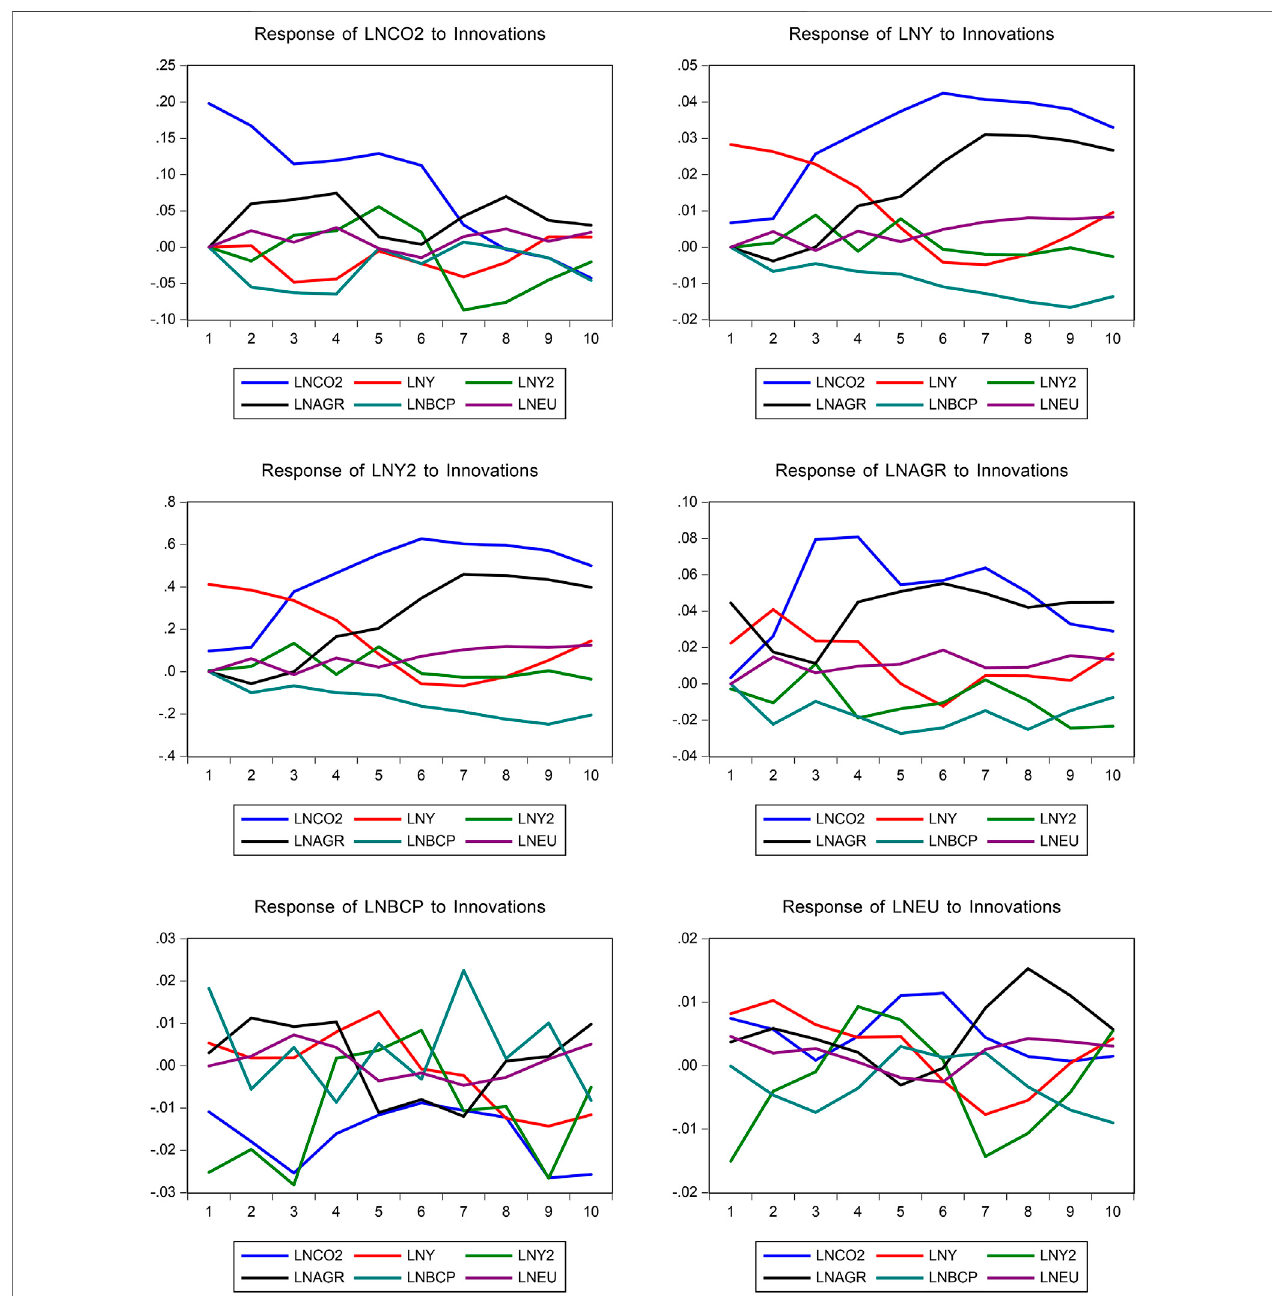
FIGURE 4 | Impulse Response Functions